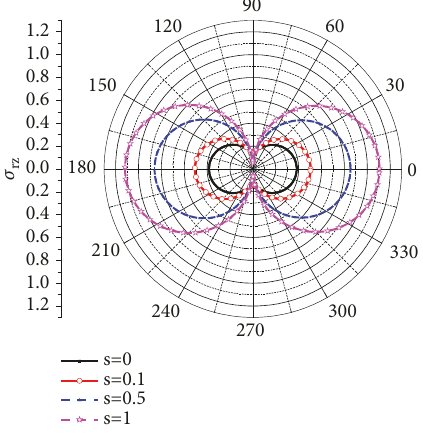
Figure 8: Effect of interface effect on the radial stress with 𝐾 𝐼 /𝐾 = 0.2 .